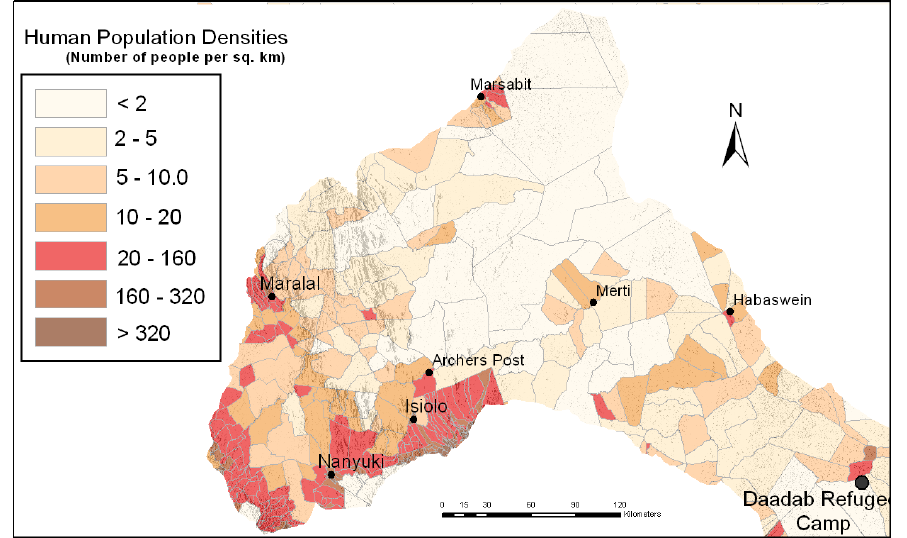
Figure 3. Human population density in 2009